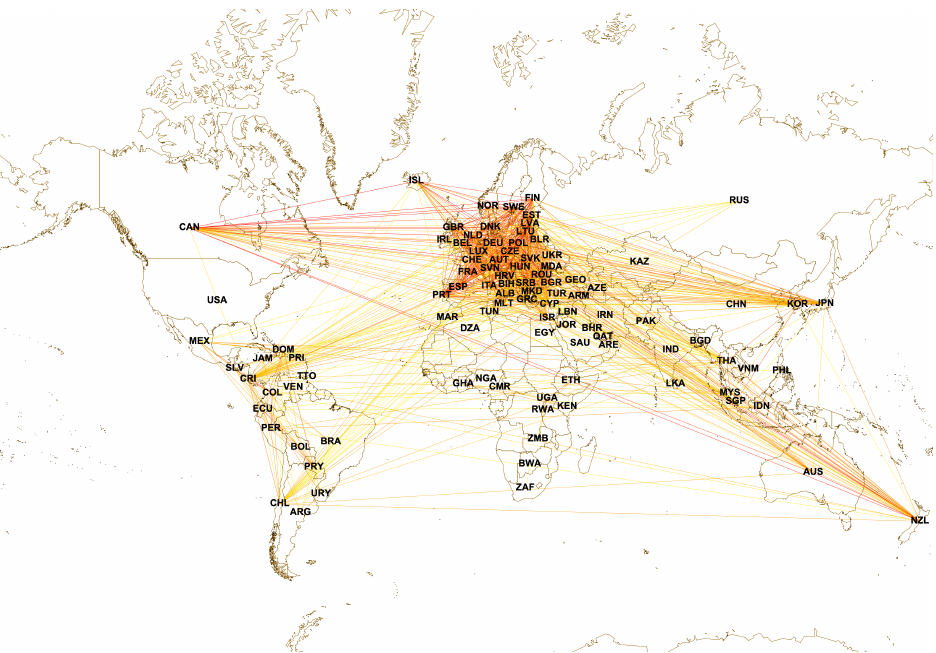
Figure 2. Similarity network of StartupBlink countries based on the values of their WDIs. Link colors are related to their weight, in ascending order from yellow to red. Only edges whose weight is equal to or greater than 0.70 are